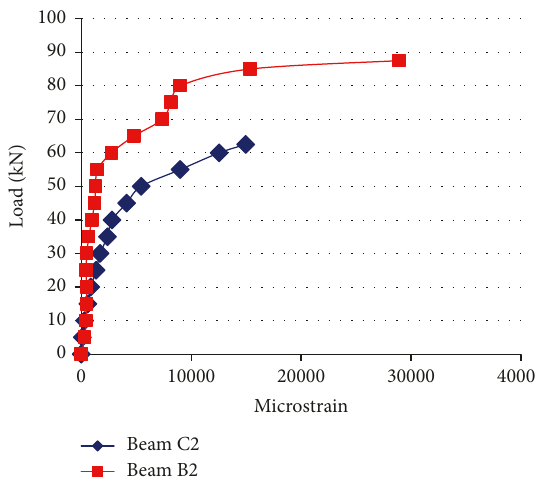
Figure 13: Effect of clear span length of the beam on load-strain response with carbon fiber